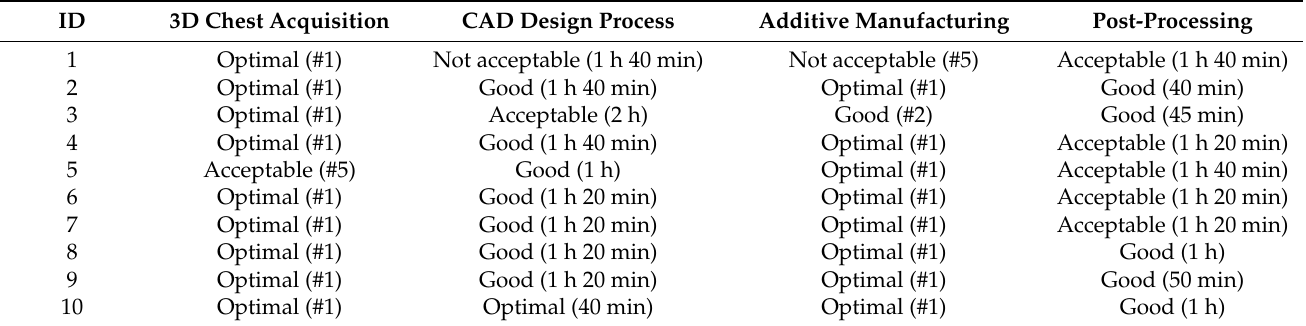
Table 4. Evaluation of the production process phases for each 3D-printed orthosis. # = Number of total